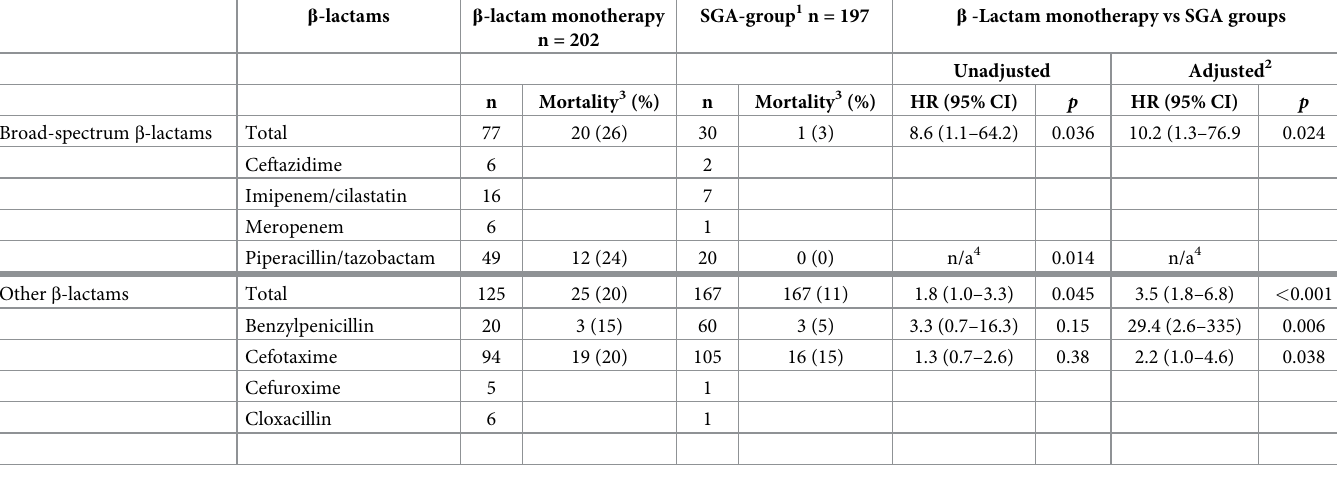
Table 3. Initial β -lactam treatment and 28-days mortality comparison between study